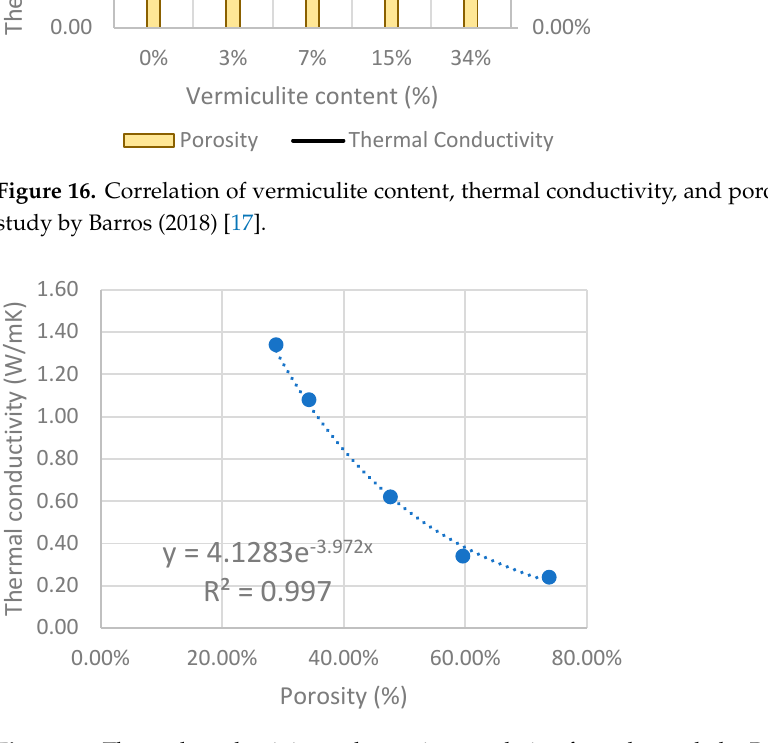
Figure 17. Thermal conductivity and porosity correlation from the study by Barros (2018) [17].